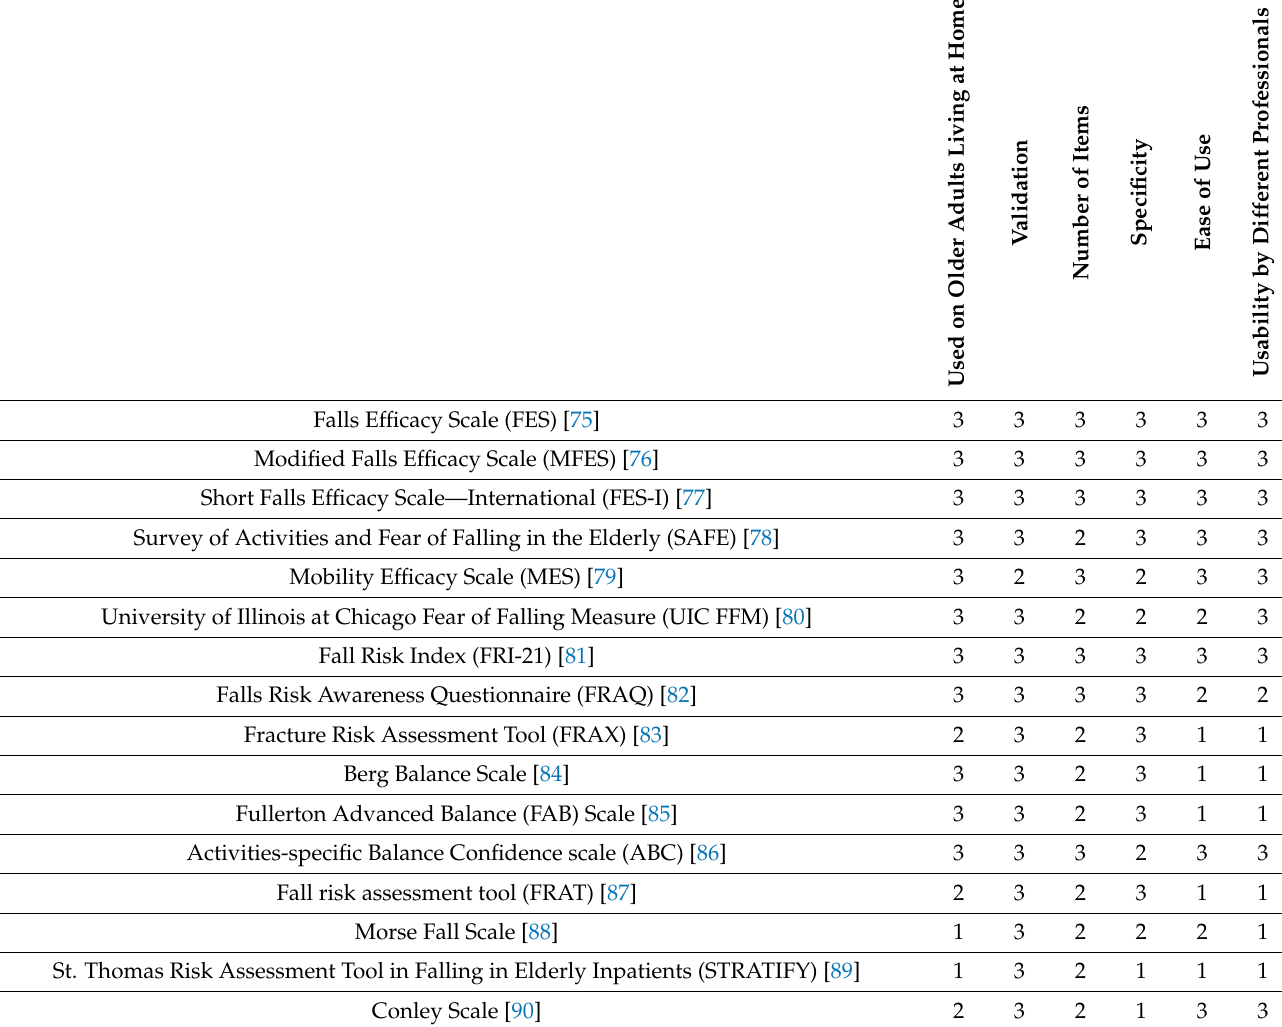
Table 5. Falls assessment tools